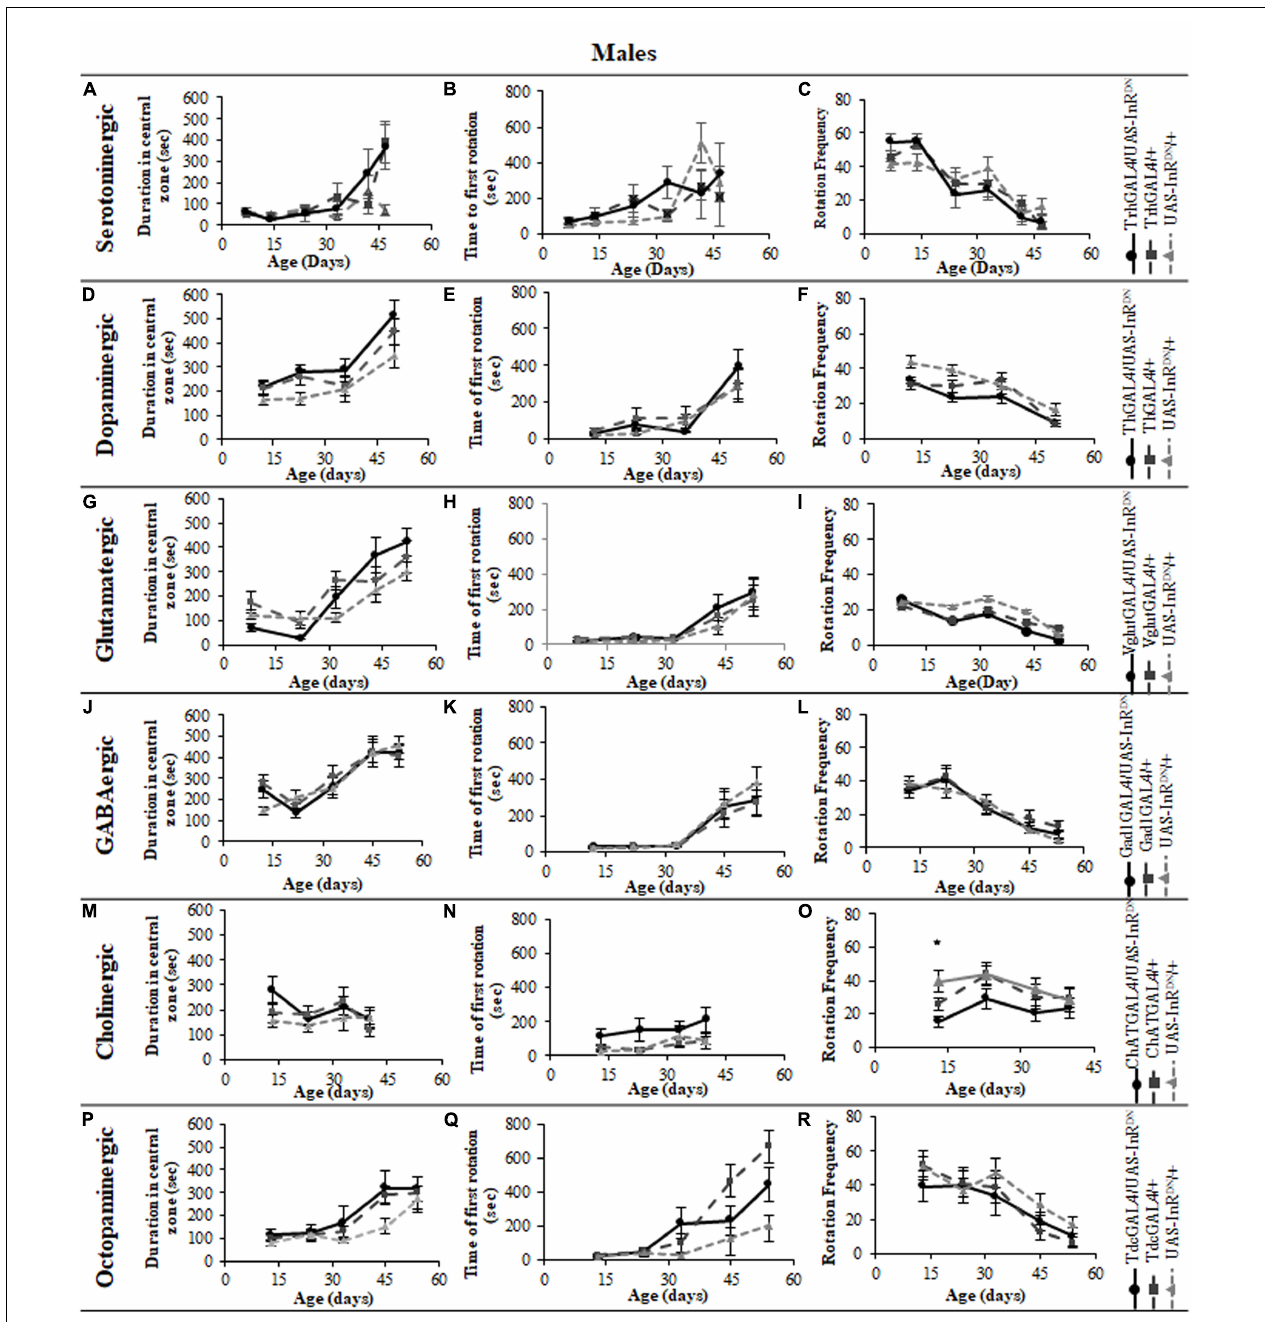
FIGURE 4 | The effect of neuronal subtype specific IIS reduction on decision making during exploratory walking senescence in female flies. Exploratory walking senescence parameters for a cohort of female flies of the indicated genotypes run in parallel with the survival experiments shown in Figure 1 . Data are shown as mean value for each parameter ± SEM, N = 16 for the indicated genotype. Data were analyzed by two-way ANOVA (age and genotype) and age was found to be a significant effect ( p < 0.05) for all genotypes. (A) Mean duration flies spent in the central zone vs. age of TrhGAL4/UAS-InR DN flies compared to TrhGAL4/ + and UAS-InR DN / + controls. (B) Mean latency to first rotation vs. age of TrhGAL4/UAS-InR DN flies compared to TrhGAL4/ + and UAS-InR DN / + controls. (C) Mean rotation frequency vs. age of TrhGAL4/UAS-InR DN flies compared to TrhGAL4/ + and UAS-InR DN / + controls. (D) Mean duration flies spent in the central zone vs. age of ThGAL4/UAS-InR DN flies compared to ThGAL4/ + and UAS-InR DN / + controls. (E) Mean latency to first rotation vs. age of ThGAL4/UAS-InR DN flies compared to ThGAL4/ + and UAS-InR DN / + controls. (F) Mean rotation frequency vs. age of ThGAL4/UAS-InR DN flies compared to ThGAL4/ + and UAS-InR DN / + controls. (G) Mean duration flies spent in the central zone vs. age of VglutGAL4/UAS-InR DN flies compared to VglutGAL4/ + and UAS-InR DN / + controls. (H) Mean latency to first rotation vs. age of VglutGAL4/UAS-InR DN flies compared to VglutGAL4/ + and UAS-InR DN / + controls. (I) Mean rotation frequency vs. age of VglutGAL4/UAS-InR DN flies compared to VglutGAL4/ + and UAS-InR DN / + controls. (J) Mean duration flies spent in the central zone vs. age of Gad1GAL4/UAS-InR DN flies compared to Gad1GAL4/ + and UAS-InR DN / + controls. (K) Mean latency to first rotation vs. age of Gad1GAL4/UAS-InR DN